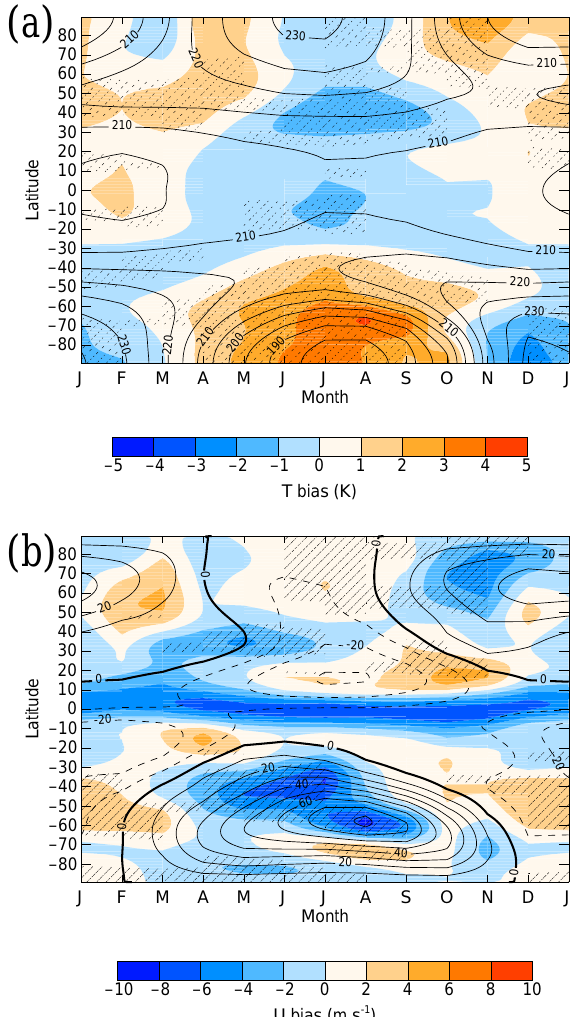
Figure 3. Biases in the climatological seasonal cycle of the REF-C1 simulation, relative to ERA-Interim, for zonal-mean (a) temperature (50hPa) and (b) zonal wind (10hPa). Black contours show ERA-I values, with contour intervals of 5K and 10ms − 1 , respectively, and coloured shading shows the bias (REF-C1 minus ERA-I), with con- tour intervals 1K and 2ms − 1 , respectively. Stippling shows regions where the bias is statistically significant at the 95% level as calcu- lated using a t test. Tick marks indicate the middle of each